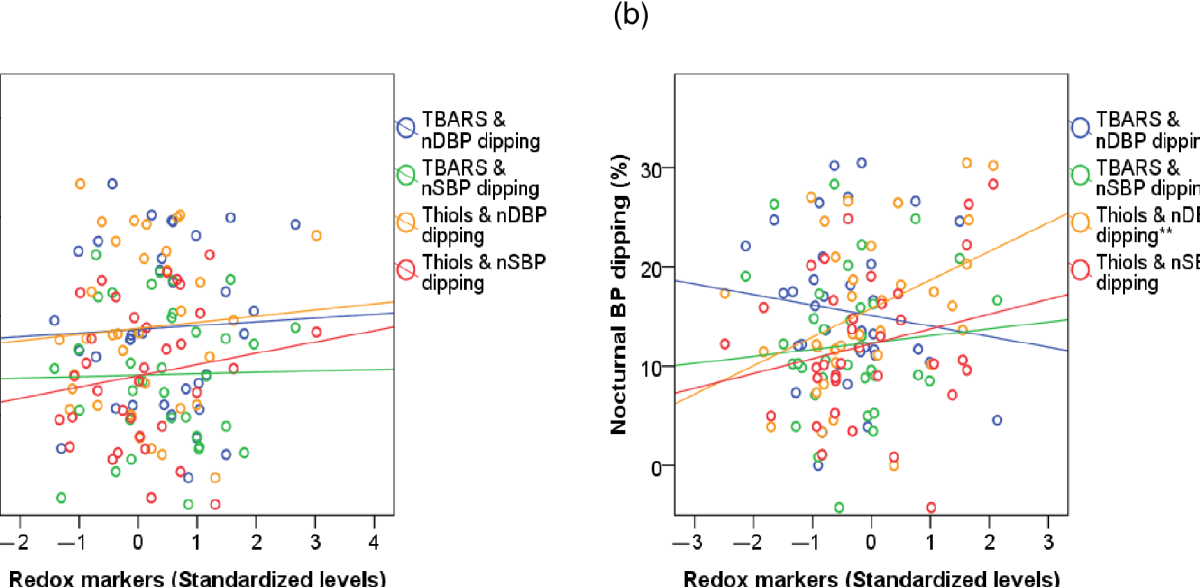
Figure 2. Correlations between redox markers and nocturnal BP decrease. (a) Patients with morning- time use of RAAS blockers. TBARS and nDBP dipping: Rho = −0.008, p = 0.965. TBARS and nSBP dipping: Rho = −0.032, p = 0.859. Reduced thiols and nDBP dipping: Rho = 0.052, p = 0.768. Reduced thiols and nSBP dipping: Rho = 0.157, p = 0.375. (b) Patients with bedtime use of RAAS blockers. TBARS and nDBP dipping: Rho = −0.157, p = 0.360. TBARS and nSBP dipping: Rho = −0.004, p = 0.983. Reduced thiols and nDBP dipping: Rho = 0.416, p = 0.012. Reduced thiols and nSBP dipping: Rho = 0.210, p = 0.220. BP−Blood pressure. RAAS−Renin-angiotensin-aldosterone system. TBARS−Thiobarbituric acid reactive substances. nDBP−Nocturnal diastolic blood pressure. nSBP−Nocturnal systolic blood pressure. Rho−Spearman’s correlation coefficient. ** refers to a p - value of less than 0.05.